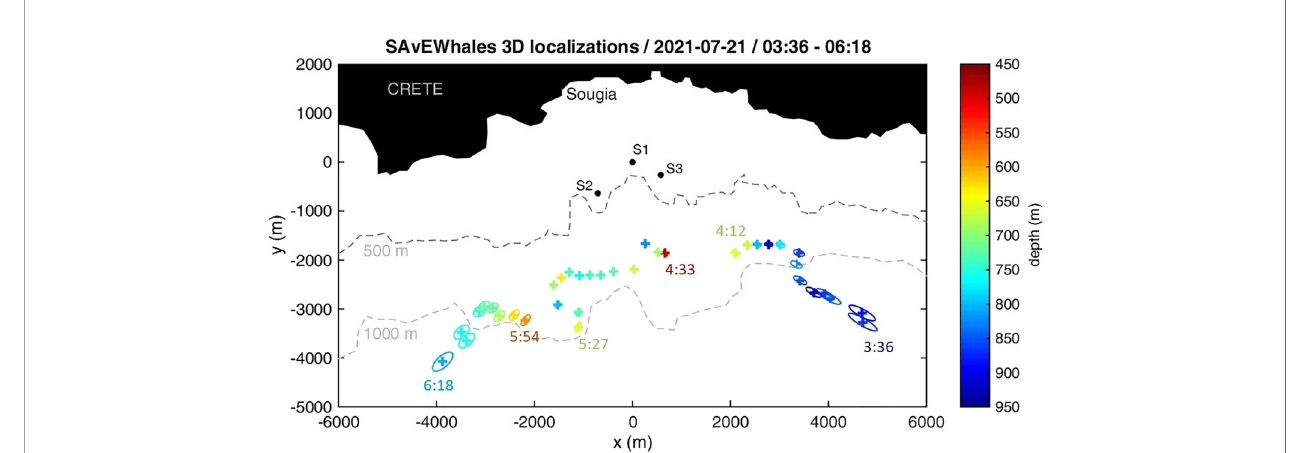
FIGURE 13 | Localization results in the horizontal and in the vertical (color scale) in the early hours of 21 July 2021, between 03:36 and 06:18, de fi ning a 3D sperm whale trajectory. A short video of this trajectory is also provided as supplementary